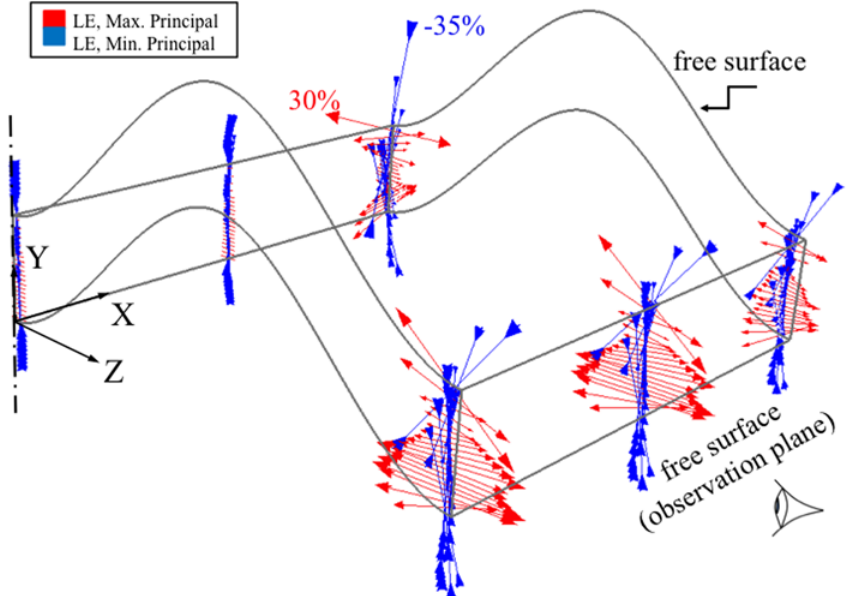
Fig 6. Principal logarithmic strain vector plots at center and at 50 μ m from one of the free surfaces of the ‘ m ’ shape growth plate. The arrows represent the maximum and minimum principal strains. The results were obtained from the mesoscale model without the details of chondrons. Regions close to the outer edges experienced a significant level of ‘ out-of-plane ’ strain. The free surfaces caused significant changes in the principal strains near the epiphyseal bone border. Tensile strains were greatest at this border and in the hypertropic zone at the calcified cartilage border and smallest at the base of the proliferative zone where cell division takes place. The centerline represents the center of the full model, as a quarter of the actual growth plate layer is shown here (XY and YZ planes are symmetry planes).